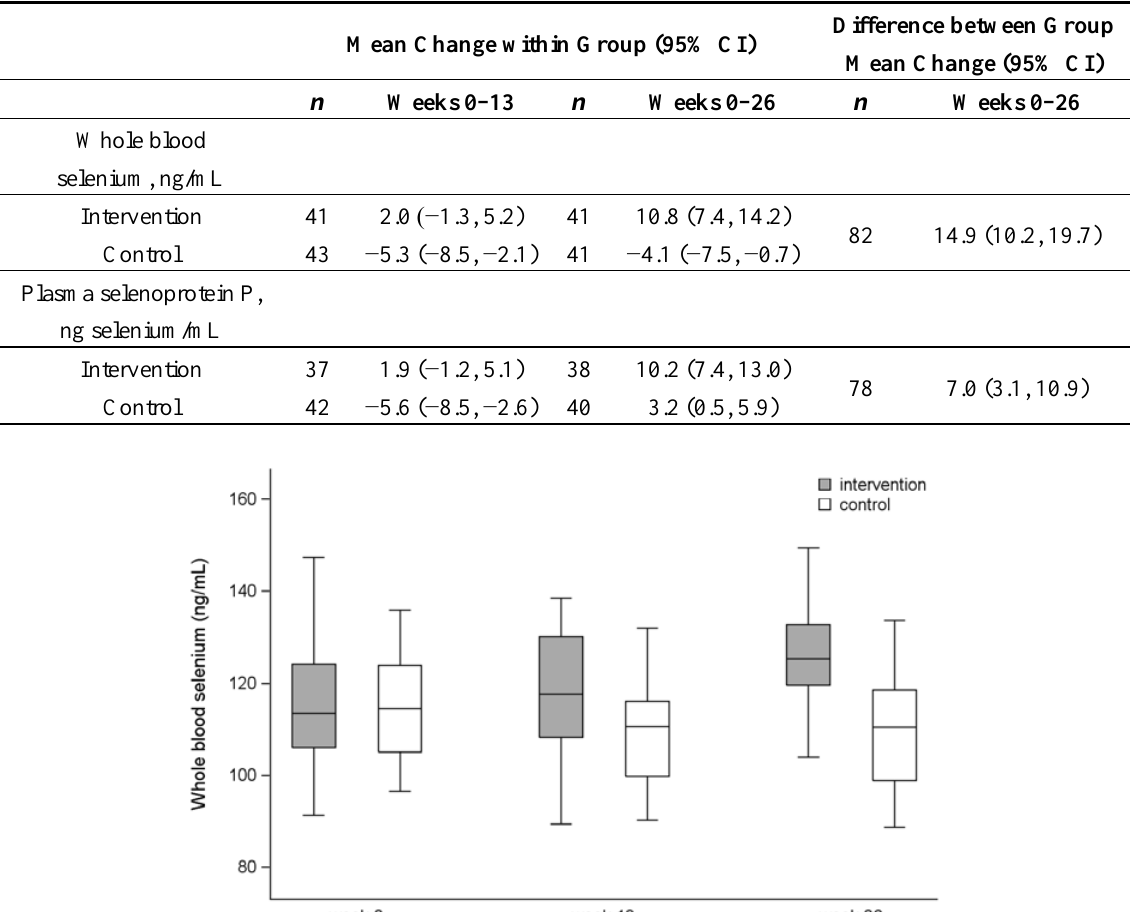
Table 2. Change within group and difference between group changes in whole blood selenium and plasma selenoprotein P concentrations.